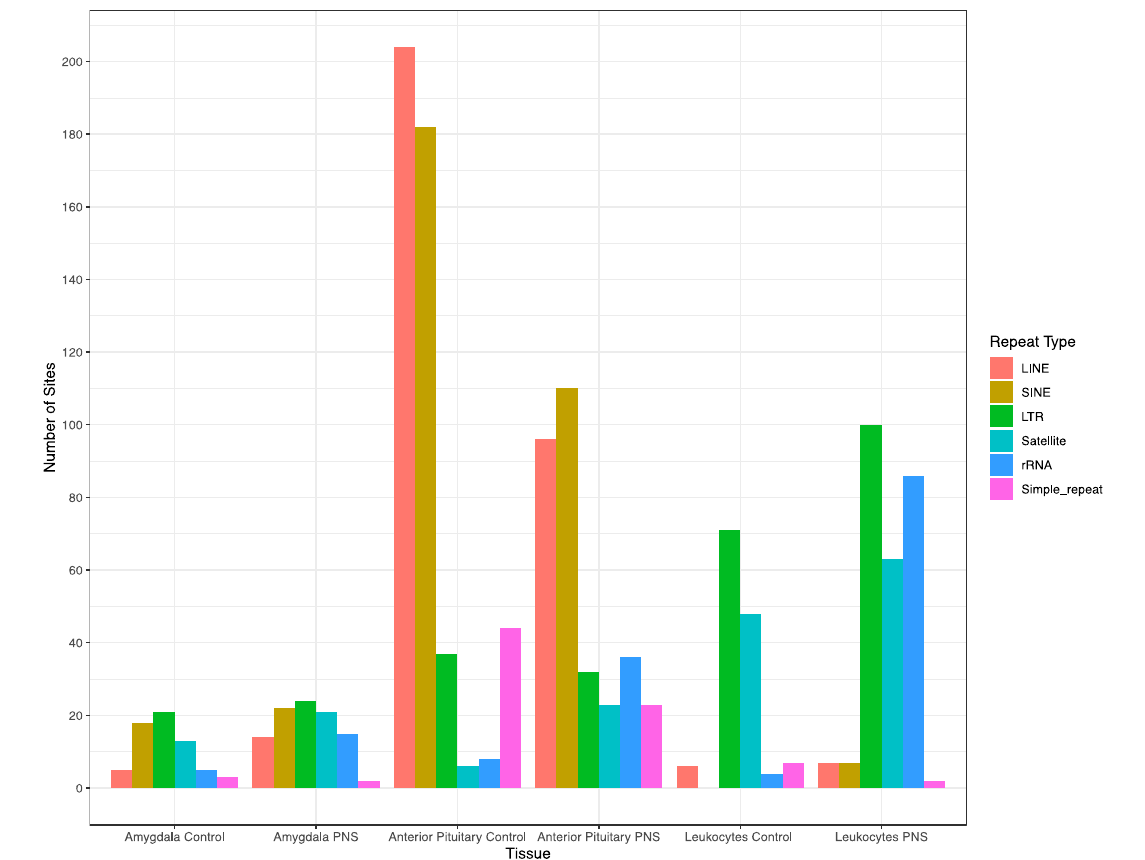
Figure 5. Number of sites with a beta value standard deviation ≥ 0.1 associated with different types of repetitive elements, long interspersed nuclear elements (LINE), short interspersed nuclear elements (SINE), long terminal repeat (LTR), satellite regions, ribosomal RNA (rRNA) and simple repeats throughout the genome. Table 2. The number of genomic features with high variability in DNA methylation between cows in the Control